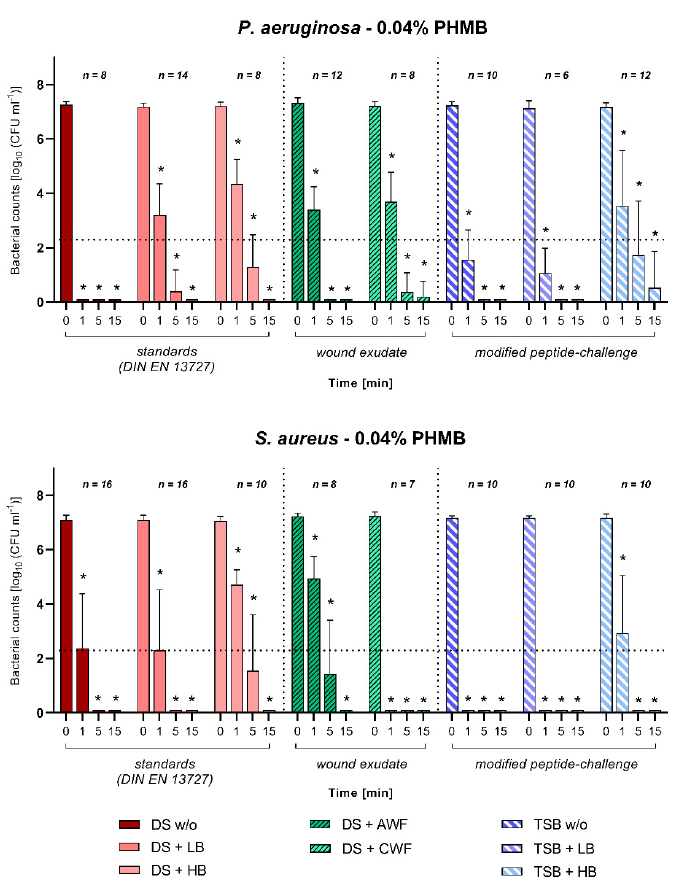
Figure 4. Antimicrobial efficacy of 0.04% polyhexanide-based (PHMB) wound irrigation solution against P. aeruginosa and S. aureus . Bacterial survival rates (in log 10 CFU/mL) after 1, 5, and 15 min of exposure time under various challenge conditions and initial bacterial counts (0 min) are displayed. First section shows the standard DIN-EN-13727 conditions of no burden (DS w/o), low burden (DS + LB), and high burden (DS + HB) prepared in regular dilution solution (DS). Second section shows results when challenged with simulated wound conditions using human acute (DS + AWF) or chronic (DS + CWF) wound exudate in DS. Third section shows results for the modified peptide- challenge prepared in tryptone soy broth (TSB) with no burden (TSB w/o), low burden (TSB + LB), and high burden (TSB + HB). Values are expressed as mean ± SD (* p ≤ 0.05 vs. 0 min) and dotted line represents a reduction in 5 log 10 cfu/mL steps compared to initial bacterial counts.